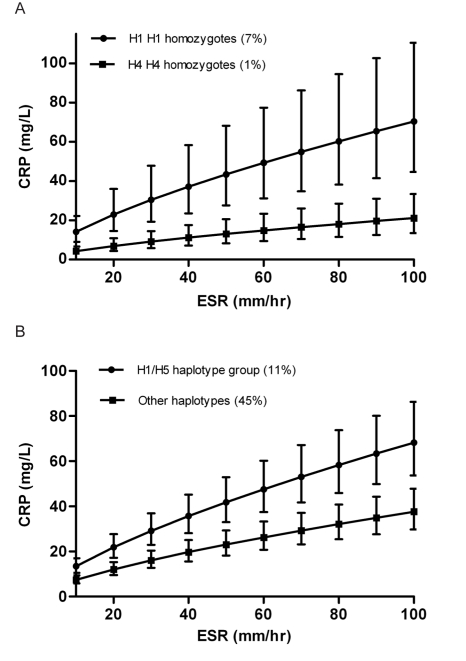
Predicted acute-phase CRP level (95% CI), stratified by haplotype, and according to the ESR-defined level of background inflammation.Annotated by the haplotype pair (A), or grouping (B), represented on the graph, with the population frequency of that combination. Data from the combined cohorts.